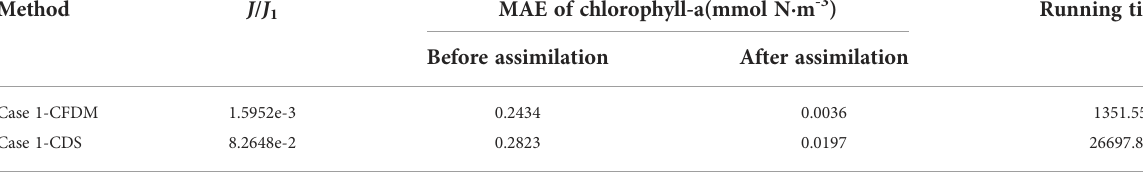
TABLE 6 The J / J 1 , MAE of chlorophyll-a and running time assimilated by different